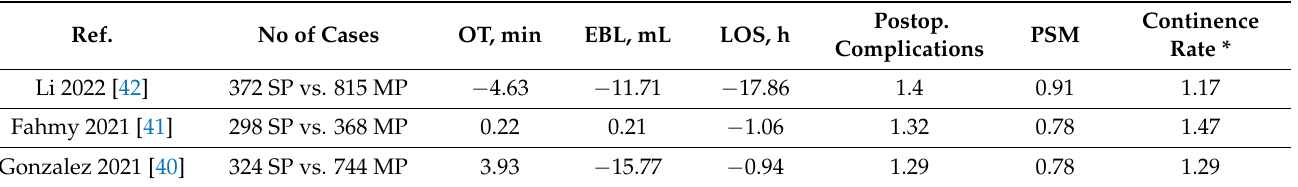
Table 3. Perioperative, functional, and oncological outcomes of SP vs. MP RALP according to published systematic reviews